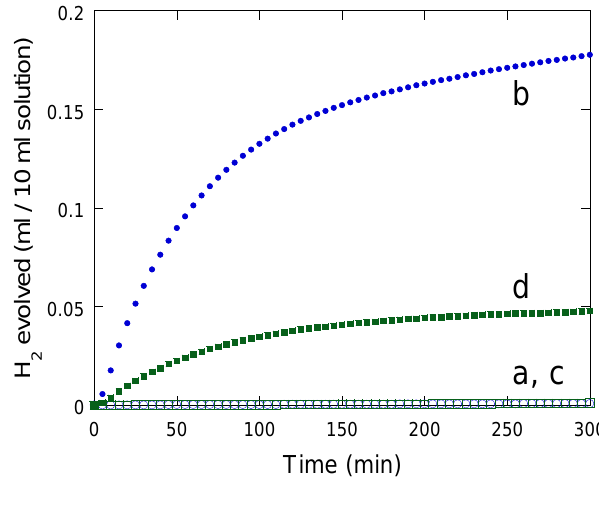
O and 2 mM MV(NO 2 ) ·2H O and 2 mM MV(NO 6 2 2